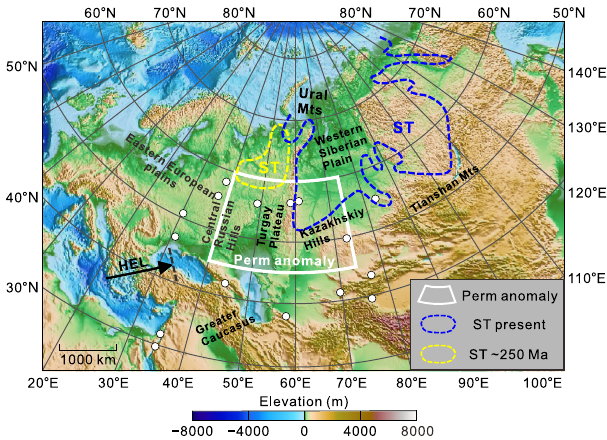
Fig. 1 | Map showing the locations ofgeomagnetic stationsand keyfeaturesin the study area. White dots indicate stations whose C-responses are used in this study.TherangeofPermanomaly 14 isshownbyzoneenclosedbywhitelines.The current 2 (blue) and past 4 (yellow) locations of the Siberian Traps (ST) are indi- cated by dashed lines. The subduction direction of the Hellenic slab (HEL) is indicated by the black arrow, with the dashed black line representing the sub- duction front 39,66